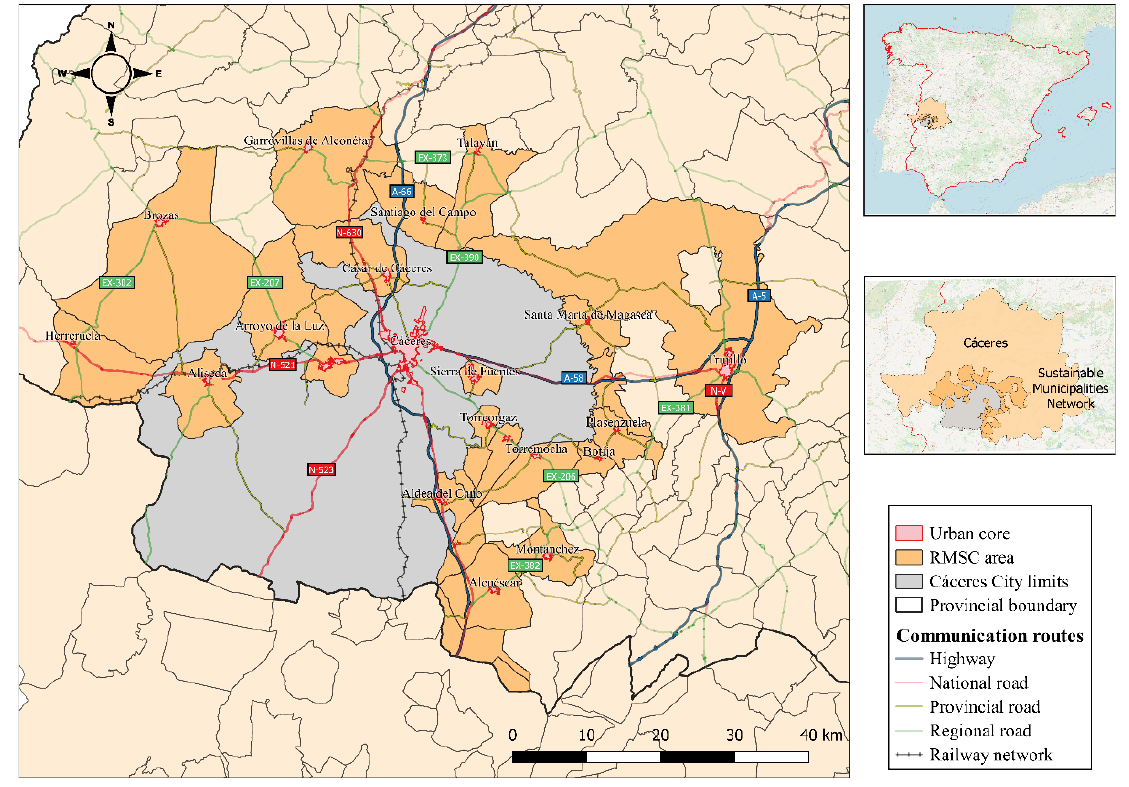
Figure 1. Location map of the study area.